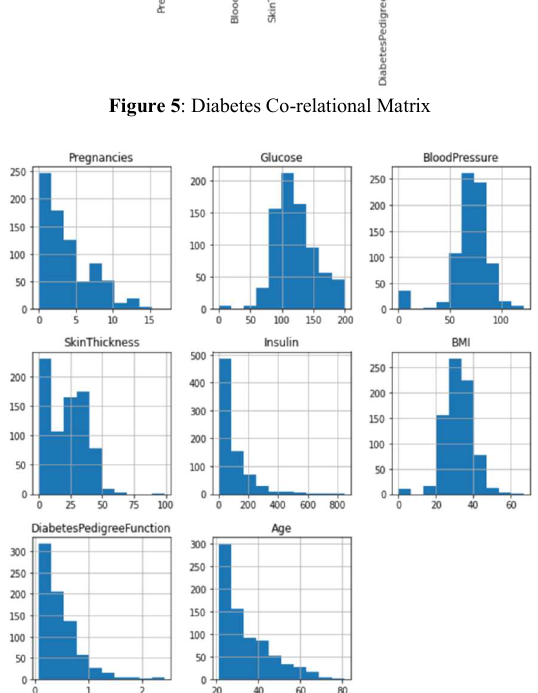
Figure 6: Diabetes Histogram Attribute Analysis